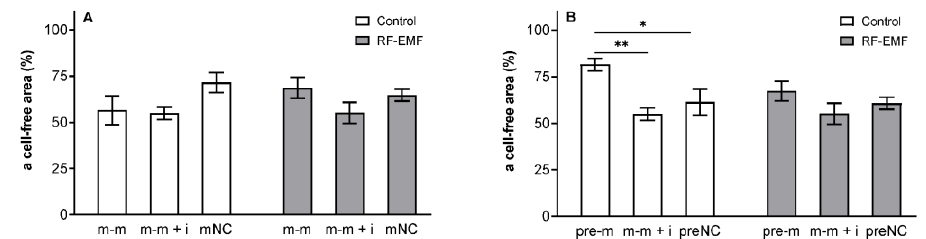
Figure 9. Effect of miR-34a administration on wound healing in DLD1 cells under control and RF-EMF conditions. Cells were transfected with ( A ) miR-34a-5p (m-m), ( B ) pre-miR-34a (pre-m), mimic of mature miR-34a together with the miR-34a inhibitor (m-m + i) or corresponding negative control of mature and pre-miRNA (mNC and preNC, respectively). Data obtained 24 h after wound generation were relativised to the corresponding cell-free area of the wound at time 0 h. Data are presented as the mean ± SEM (n = 4). Two-way ANOVA, Tukey ’ s post hoc test, * p < 0.05, ** p < 0.01.